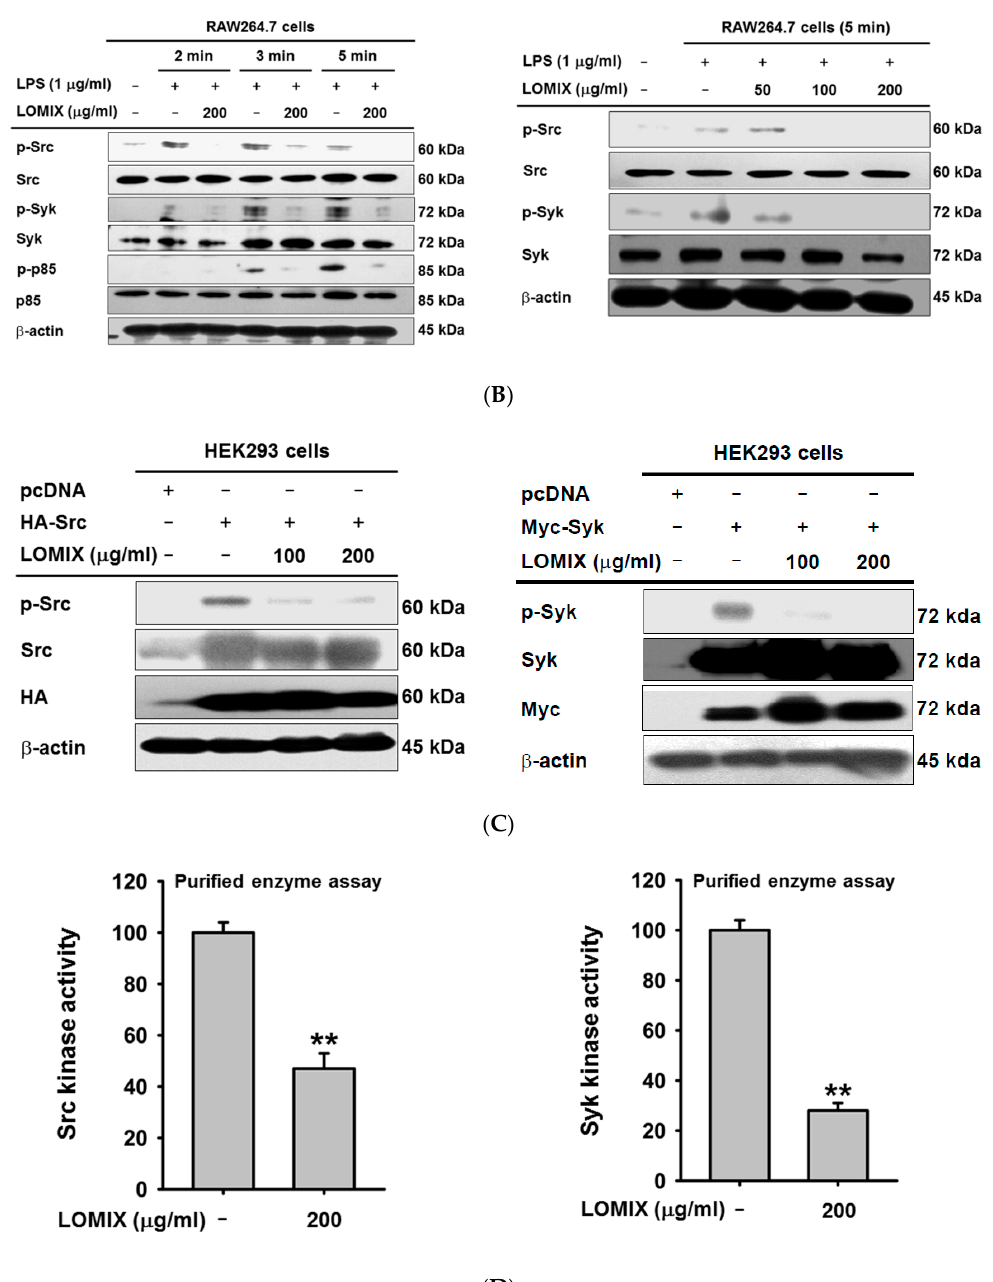
Figure 3. LOMIX suppresses NF- κ B signaling. RAW264.7 cells pretreated with LOMIX (200 µg/mL) for 30 min were treated with LPS (1 µg/mL) for the indicated time. ( A ) p-I κ B α and I κ B α in whole cell lysates were detected by Western blot analysis. ( B left ) RAW264.7 cells pretreated with LOMIX (200 µg/mL) for 30 min were treated with LPS (1 µg/mL) for the indicated time, and p-Src, Src, p-Syk, Syk, p-p85, and p85 in whole cell lysates were detected by Western blot analysis. ( B right ) RAW264.7 cells pretreated with the indicated doses of LOMIX for 30 min were treated with LPS (1 µg/mL) for 5 min, and p-Src, Src, p-Syk, and Syk in whole cell lysates were detected by Western blot analysis. ( C ) HEK293 cells pretreated with the indicated doses of LOMIX for 24 h were transfected with the indicated plasmids for another 24 h, and p-Src, Src, p-Syk, Syk, and hemagglutinin (HA) in whole cell lysates were detected by Western blot analysis. β -actin and lamin A/C were used as internal controls for whole cell and nuclear lysates, respectively. ( D ) Inhibitory activity of LOMIX on Src and Syk kinase activities was determined by an in vitro kinase assay with purified enzymes. ** p < 0.01 compared to the vehicle-treated